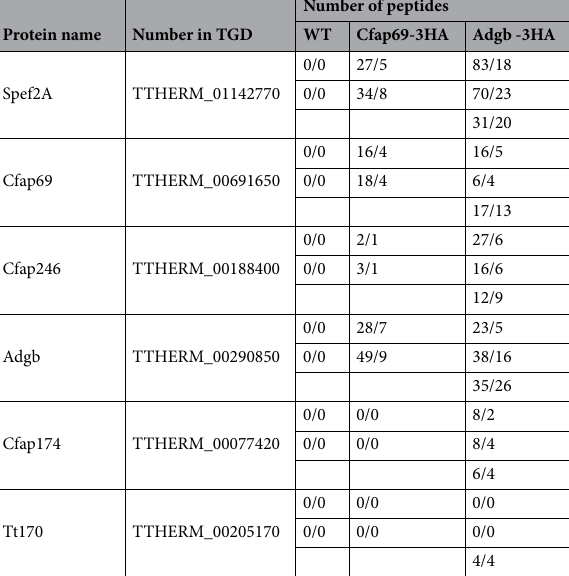
Table 2. Mass spectrometry-based identification of the ciliary proteins co-immunoprecipitated with Cfap69- 3HA or Adgb-3HA. Table shows the numbers X/Y; (X) number of all identified peptides (in a Mascot program, all significant matches), (Y) number of all unique peptide sequences (in a Mascot program, significant sequences). Data in rows represent data from independent experiments (complete data are presented in S5